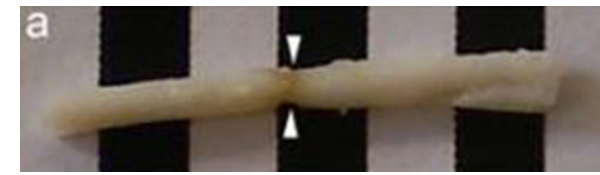
Figure 1. Spinal cord tissue of a CX3CR1 mouse: length is typi- cally about 25–35mm and diameter is about